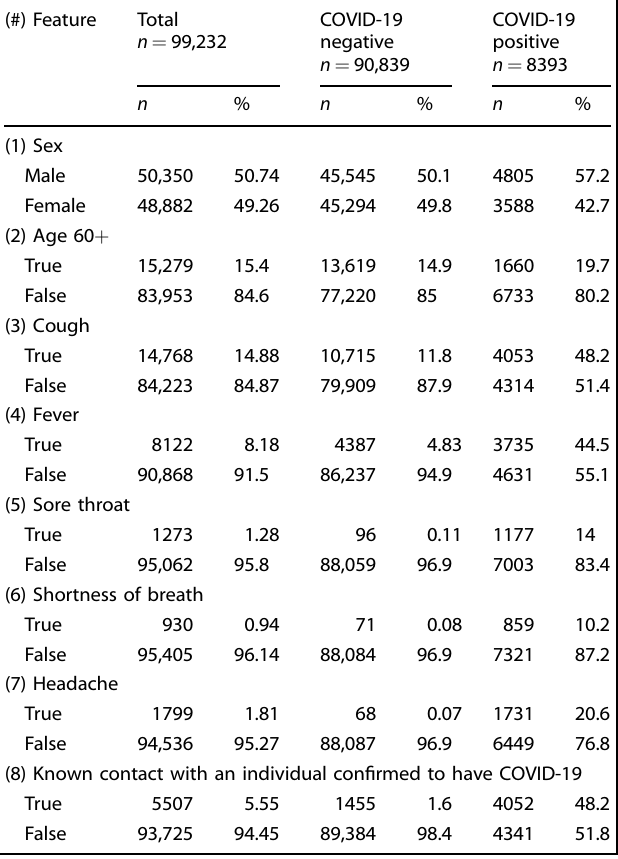
Table 1. Characteristics of the dataset and the features used by the model in this study.